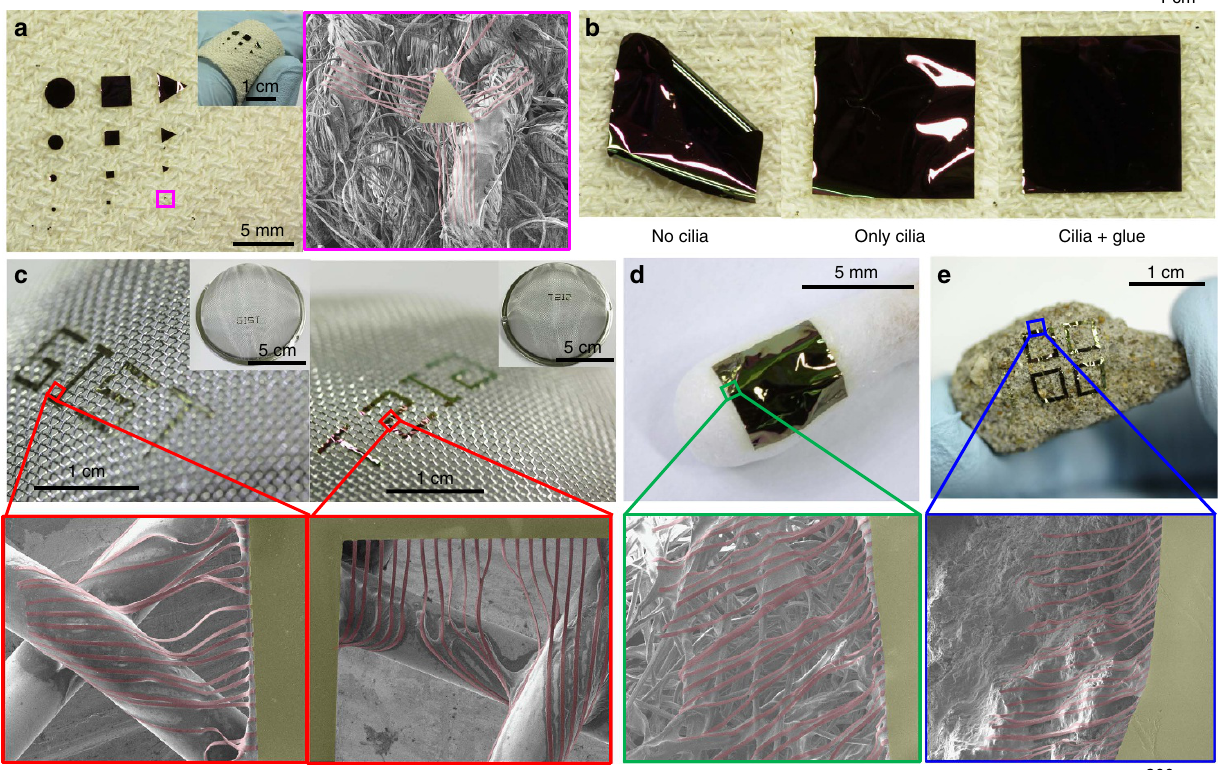
Figure 4 | Examples of transfer printing on complex surfaces. ( a – e ) Photographs and/or magnified SEM images of various PI patterns with cilia (thickness ¼ 1.8 m m, width ¼ 10 m m, length ¼ 600 m m, density ¼ 30mm (cid:3) 1 ) transferred onto a bandage ( a , b ), a tea strainer ( c ), a cotton swab ( d ) and a stone ( e ). Diluted PDMS solution (3.3 wt% in toluene) was used as glue. During the transfer process, the PMMA layer faces the target substrates except for the sample used in c -right. The PI patterns other than cilia were deposited with a Cr layer (thickness ¼ 70nm) for high optical